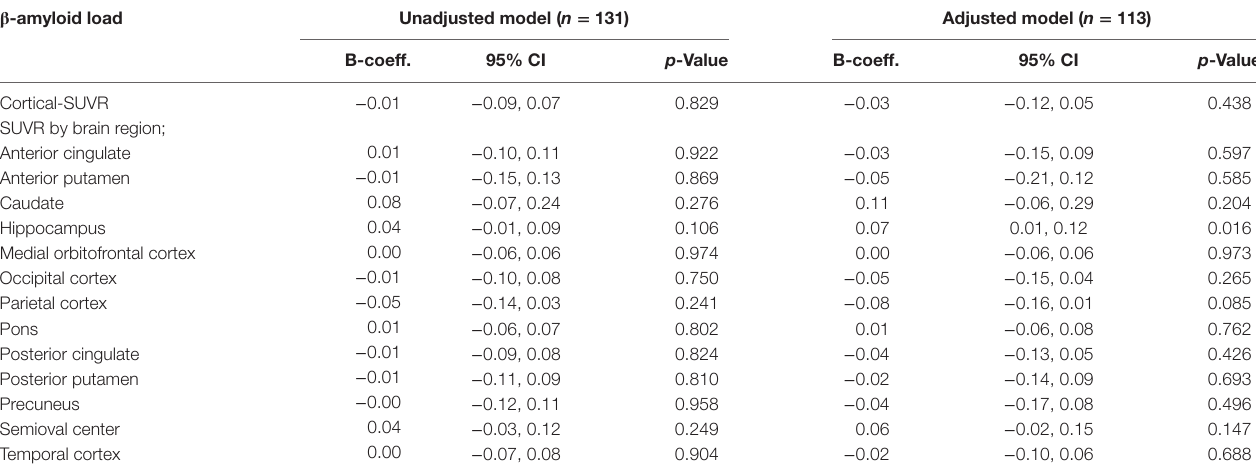
TaBle 3 | Multiple linear regressions examining the cross-sectional associations between fatigue at the clinical exam closest to PET-scan and cerebral β -amyloid load in subjects with a CDR score of 0.5.